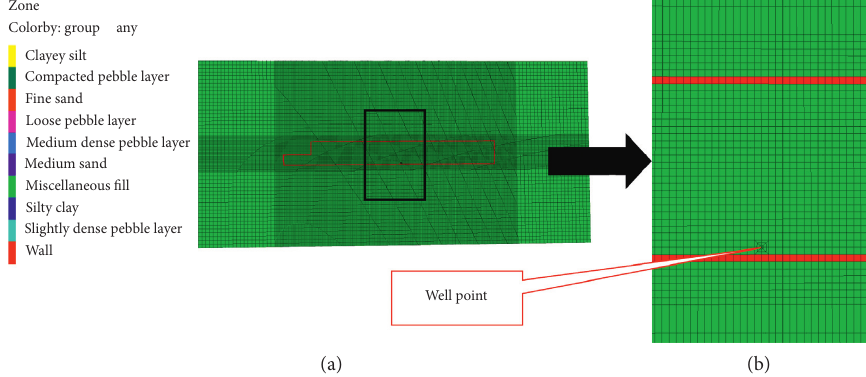
Figure 15: Layout of the single well model.